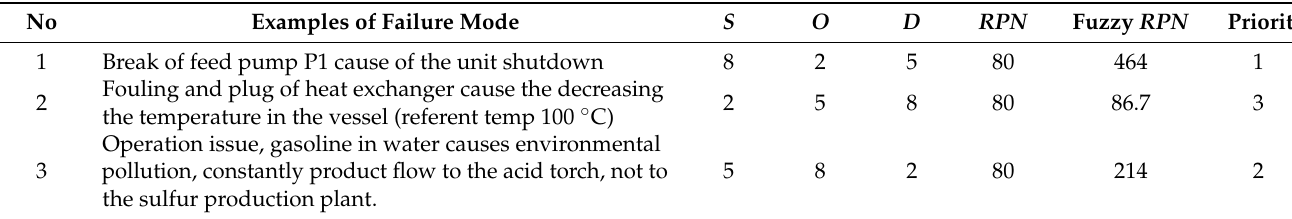
Table 9. Example of risk